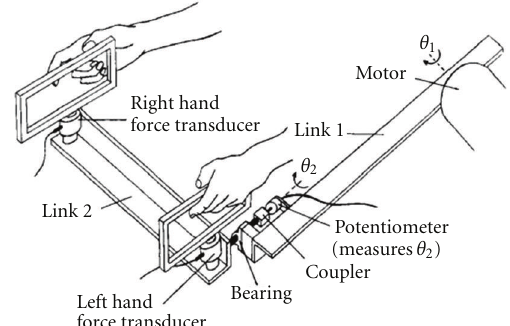
Figure 8: The Bimanual Lifting Rehabilitator. Reprinted with